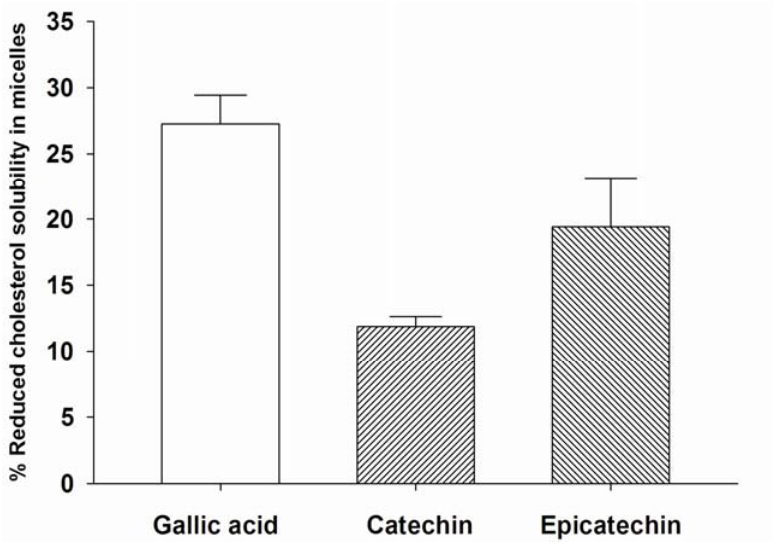
Figure 3. The percentage reduced cholesterol solubility in micelles of gallic acid, catechin, and epicatechin. Results are expressed as mean ± S.E.M. , n =